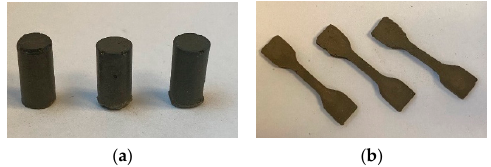
Figure 1. ( a ) Representative photos of compressive cylinders and ( b ) of tensile strength dog-bone- shaped test samples of terpenoid-sulfur composites. Tensile measurements were taken on dog bone-shaped samples (Figure 1) with a Mark-10 ES30 Manual Test Stand equipped with a Mark 10 Force Gauge (Model M3-2 or Model M3-200). The tensile specimens were clamped down with a Mark 10 wedge grip (Model G1061-1). Tensile specimens were cut or moulded into dog bone shapes with di- mensions as depicted in Figure S3 of the Supporting Information File. Samples of I-BPA 80 were approximately 1.2 mm in thickness, while R-BPA 80 samples were approximately 2.5 mm in thickness. The actual thicknesses were individually measured at positions on each sample using callipers and average values were used for calculations. The data reported are an average of runs on five different samples.